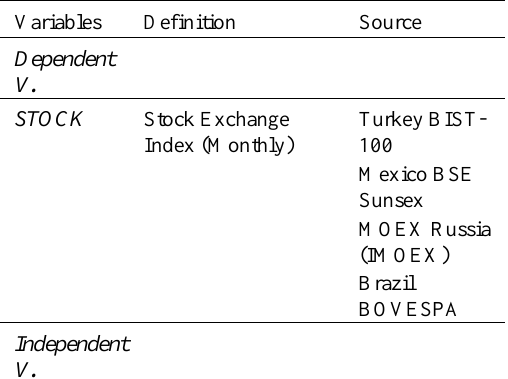
Table 1: Dependent and Independent